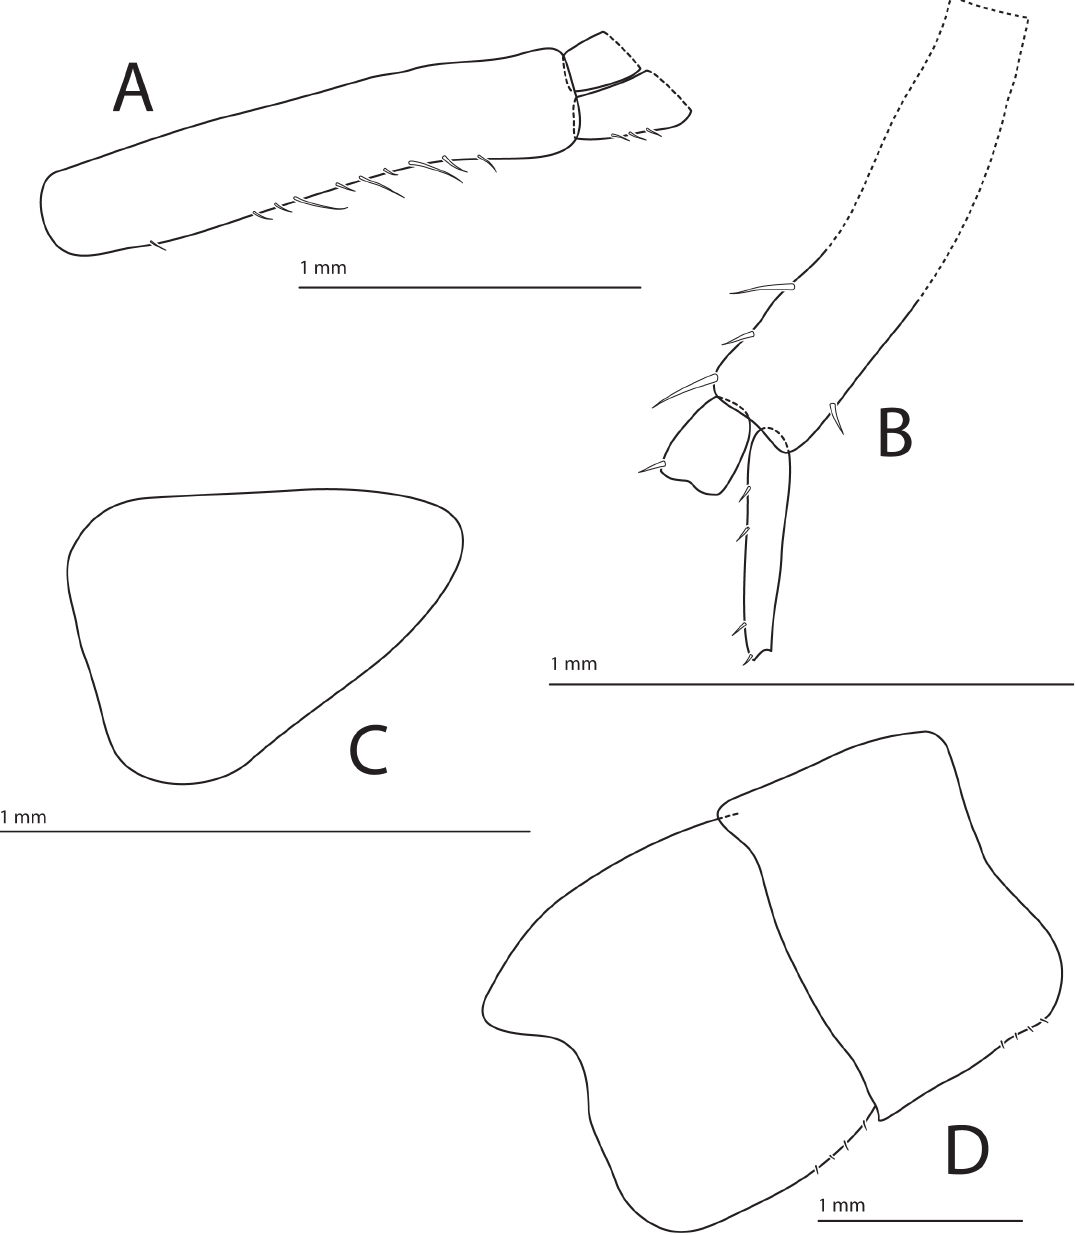
Fig. 7. Halirages helgae sp. nov., holotype, ♀ , 10 mm long. A . Uropod 1. B . Uropod 2. C . Telson. D . Epimeron